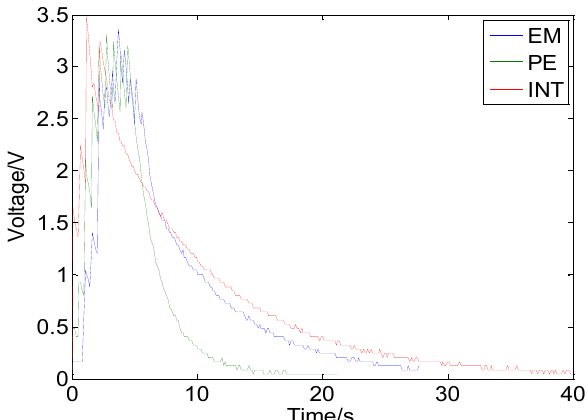
Figure 10: The output voltage from the energy harvesting device along with the individual methods, Electromagnetic, Piezoelectric and Integrated approaches.